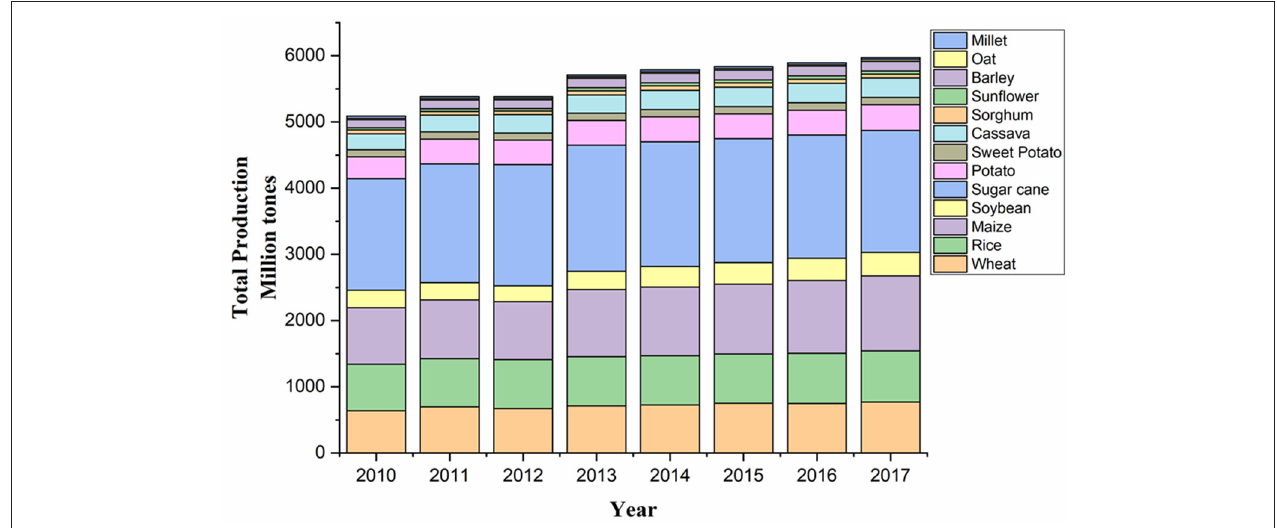
FIGURE 2 | Graphical representation of the total production of major crops in the world (2010–2017). Source: Data retrieved from FAOSTAT 1